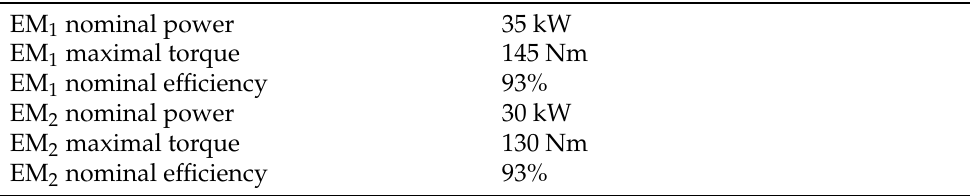
Table 3. Main properties of proposed electric